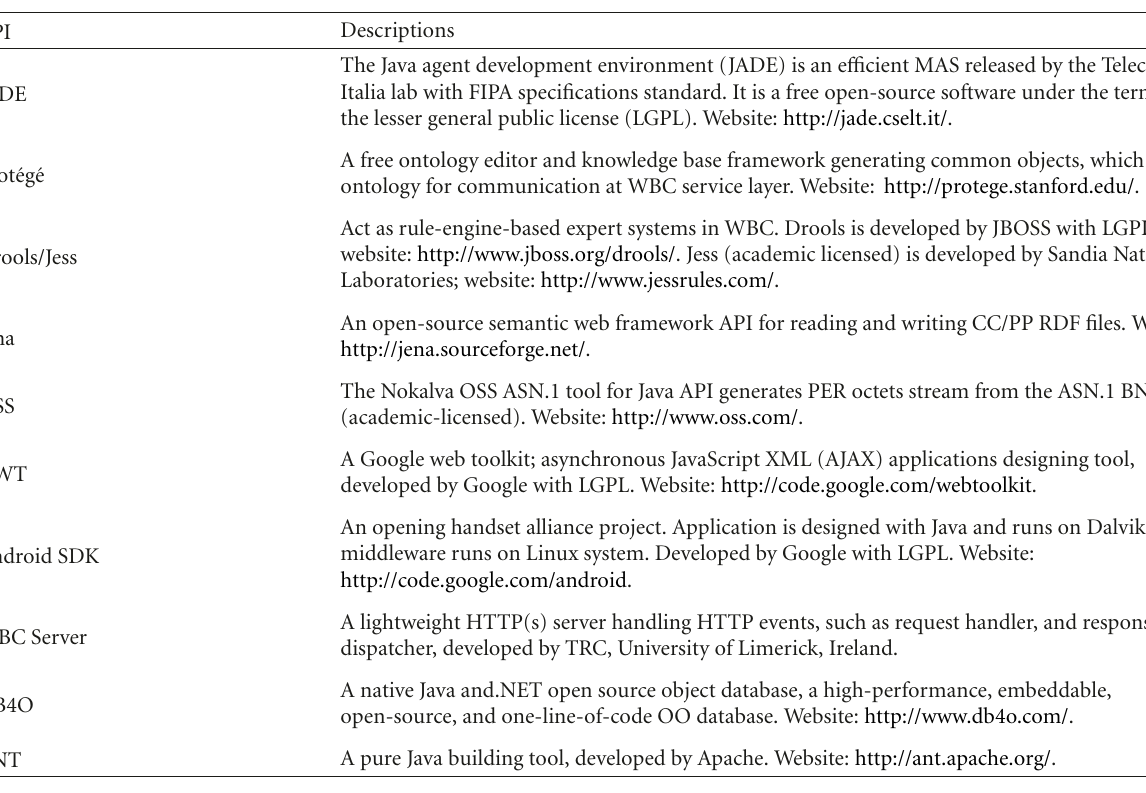
Table 4: The Main APIs at the WBC Service